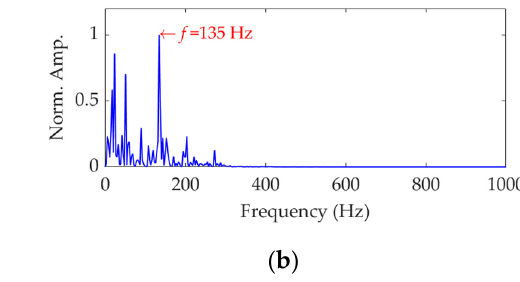
Figure 26. The optimal target mode: ( a ) time − domain waveform and ( b ) SES.